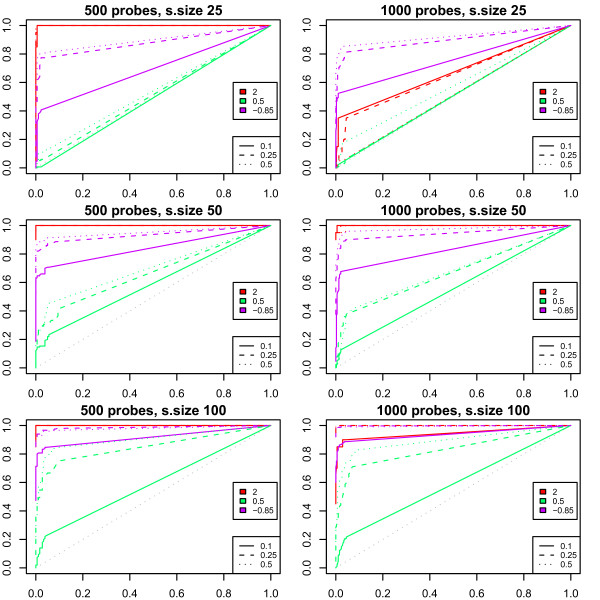
Receiver-operator characteristic curves for the simulation study. Conditions shown are: sample size 25, 50 and 100 (rows from top to bottom); length of the studied region 500 and 1000 probes (columns from left to right); proportion of samples with each effect 10, 25 and 50 percent (solid, dashed and dotted lines); and copy number effect sizes 2, 0.5 and -0.85 (line colours red, green and purple). For details about the study setup, see appendix.